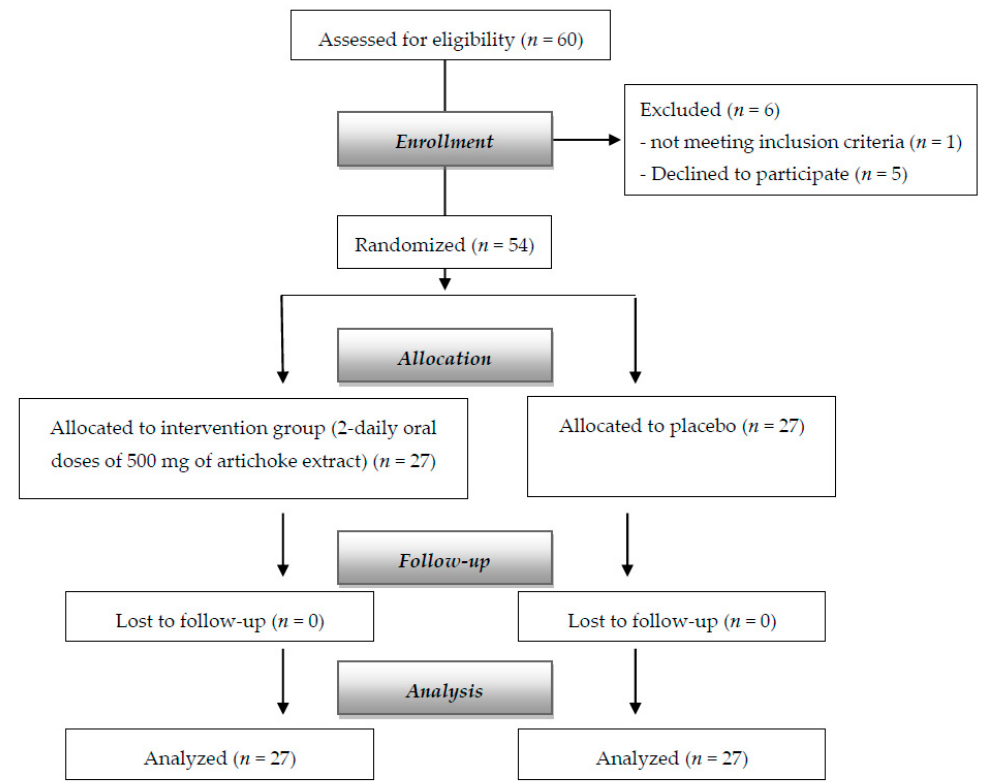
Figure 1. Flow diagram of the study.